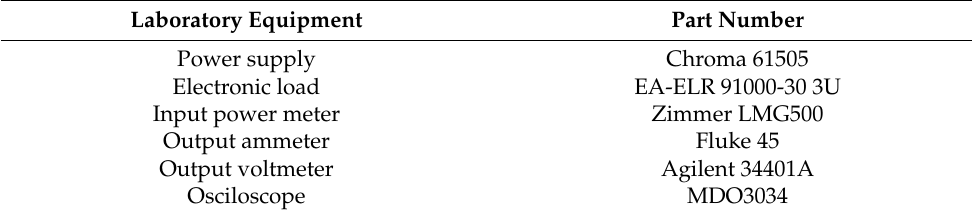
Table 1. Type designation of used laboratory